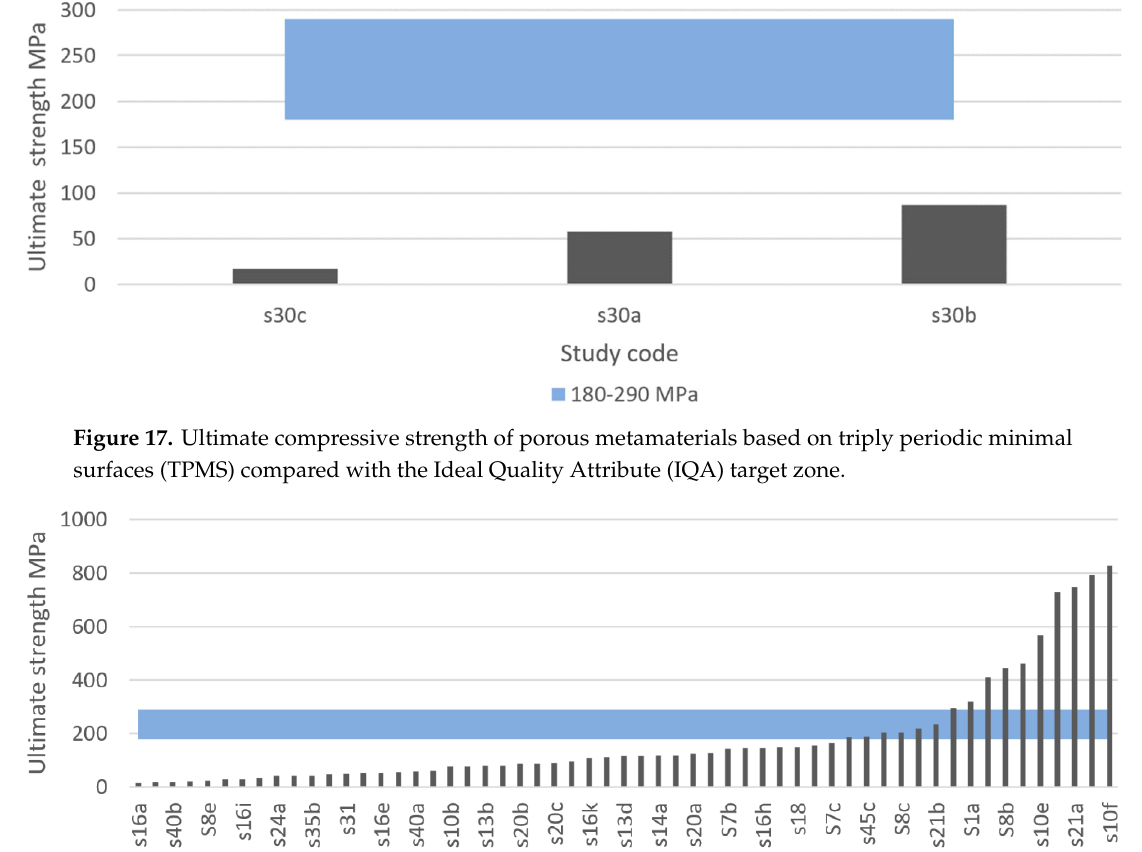
Figure 17. Ultimate compressive strength of porous metamaterials based on triply periodic minimal surfaces (TPMS) compared with the Ideal Quality Attribute (IQA) target zone.